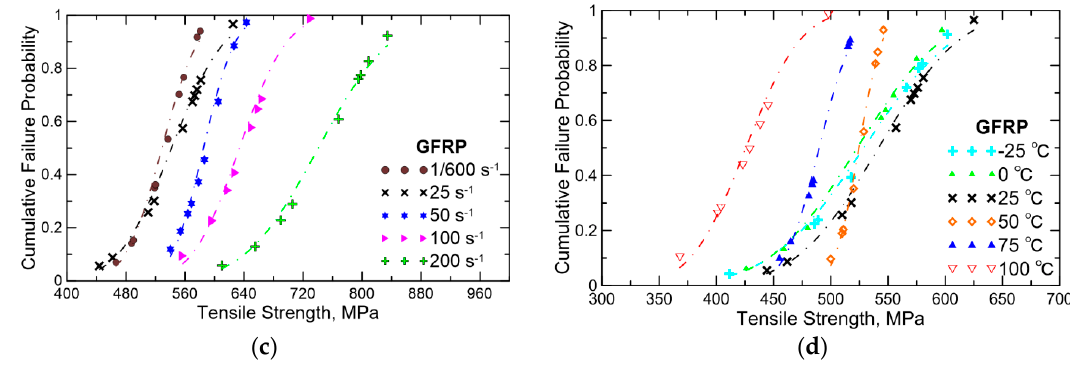
Figure 14. Cumulative failure probability versus tensile strength of ( a , b ) glass yarn and ( c , d ) GFRP under different strain rates and temperatures.